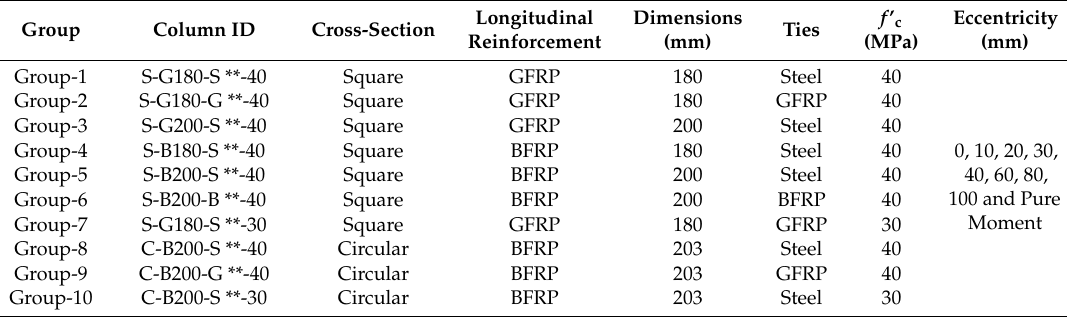
Table 5. List of groups of RC columns considered in the FE parametric analysis.